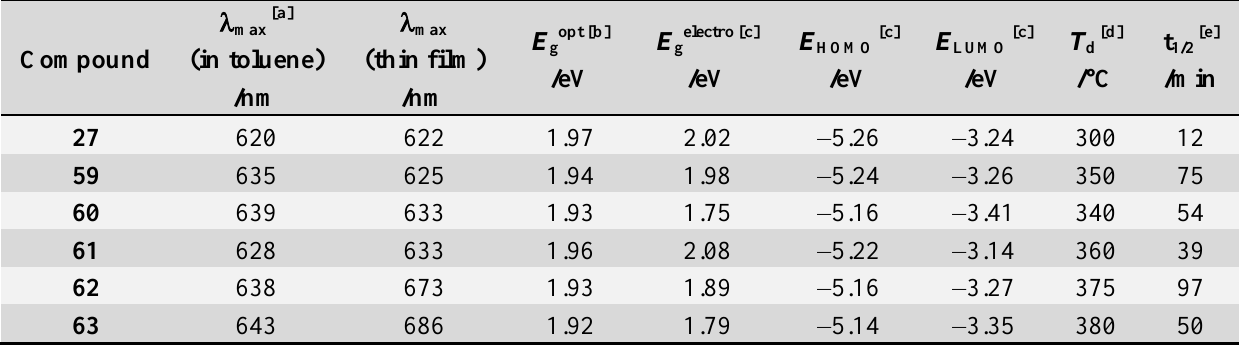
[a] Lowest-energy absorption maximum . [b] Optical band gap ( E gopt ) determined from the onset of the lowest-energy visible absorption band. The onset was defined as the intersection between the baseline and the tangent line that touches the point of inflection. [c] E